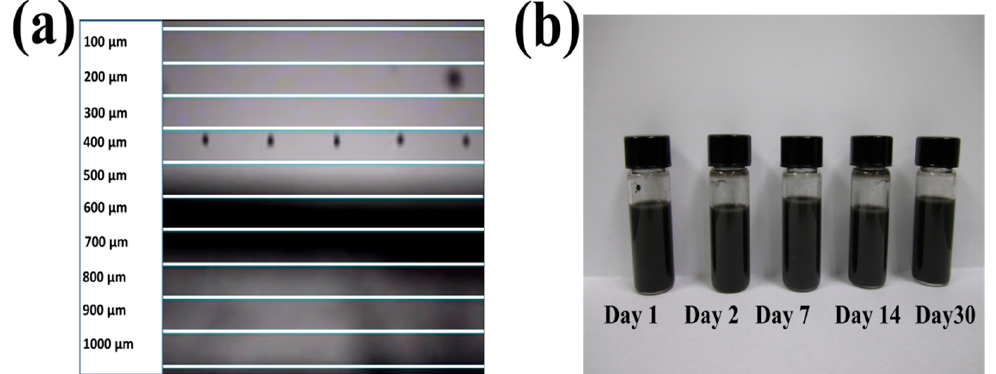
Figure 4. ( a ) Inkjet drops from 10 pL nozzle; ( b ) stability of synthesized ink aged for different times, all inks were kept in a refrigerator at 4 °C.